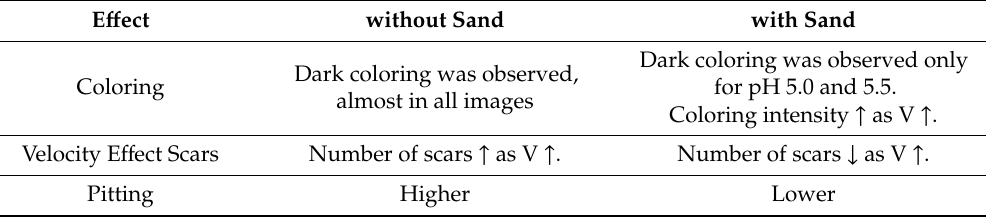
Figure 4. Pictures of API 5L X65 specimens after testing in CO 2 erosion–corrosion (EC) with sand at three pH levels (4.5, 5.0, 5.5), three angles (15°, 45°, 90°), two velocities (8, 16 m/s), and at room temperature. Table 1. Summary of visual observations for all tested